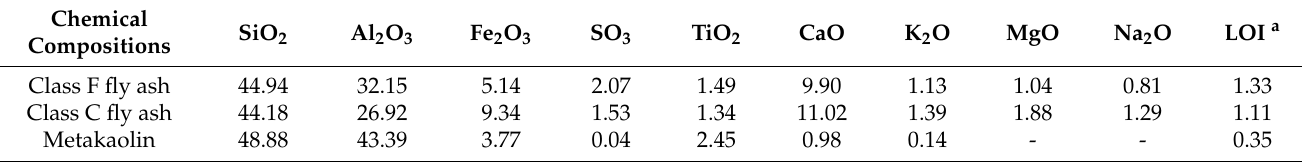
Table 1. Chemical compositions of binding materials (wt.%).